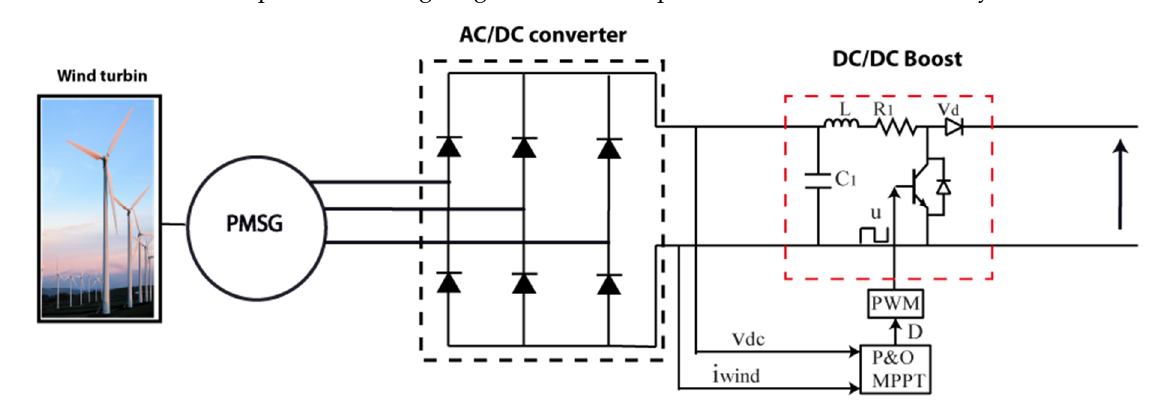
Figure 6. Wind turbine system.